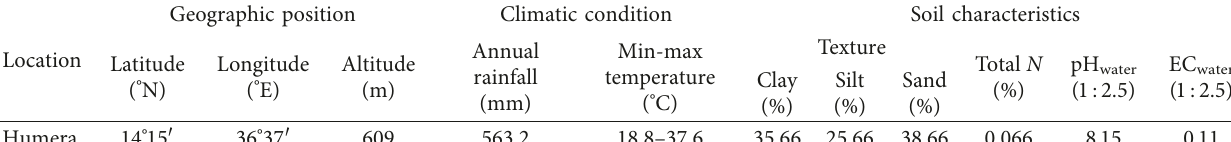
Table 1: Geographic position, soil property, and climatic condition description of the study area.